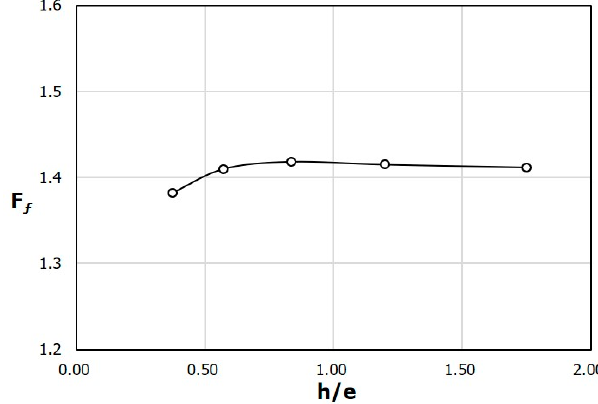
Figure 16. Variation of F ƒ with h/e (rib area = 375 mm 2 ).